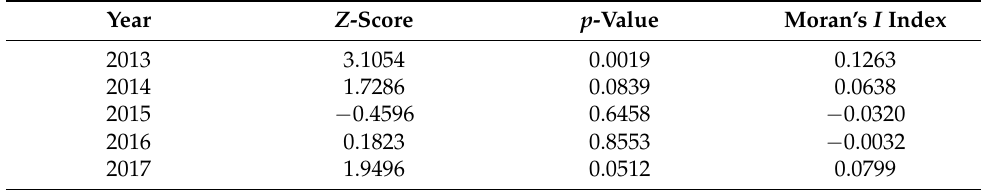
Table 7. Z -scores for the years